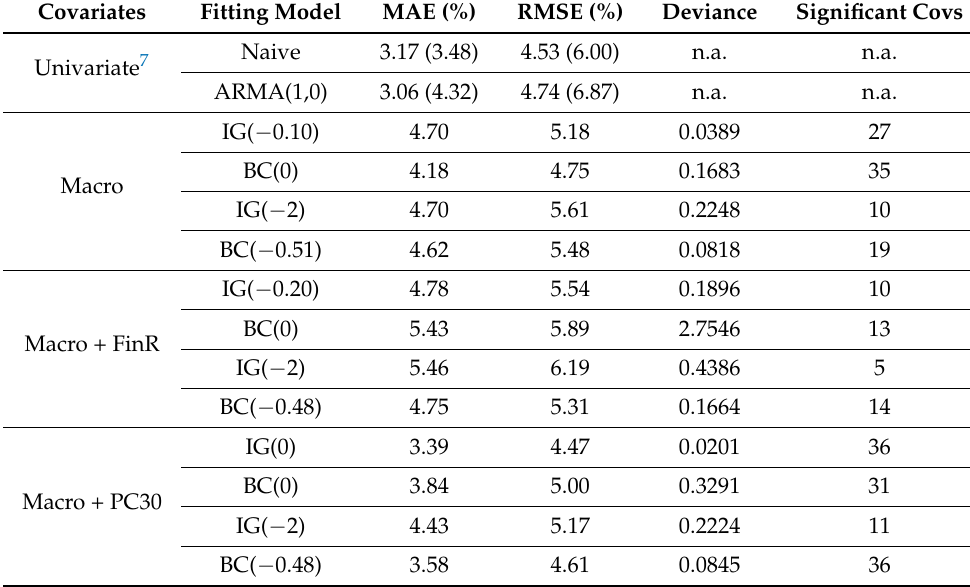
Table 5. Fitting error evaluation summary: